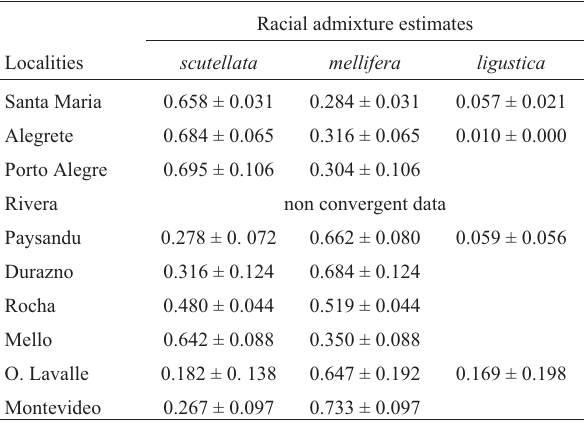
Table 3 - Racial admixture estimates in honeybee populations from southern Brazil and Uruguay, according to the Krieger et al . (1965) method, based on allele frequencies of Mdh-1 and Hk loci (for parental frequencies, see Lobo et al. ,